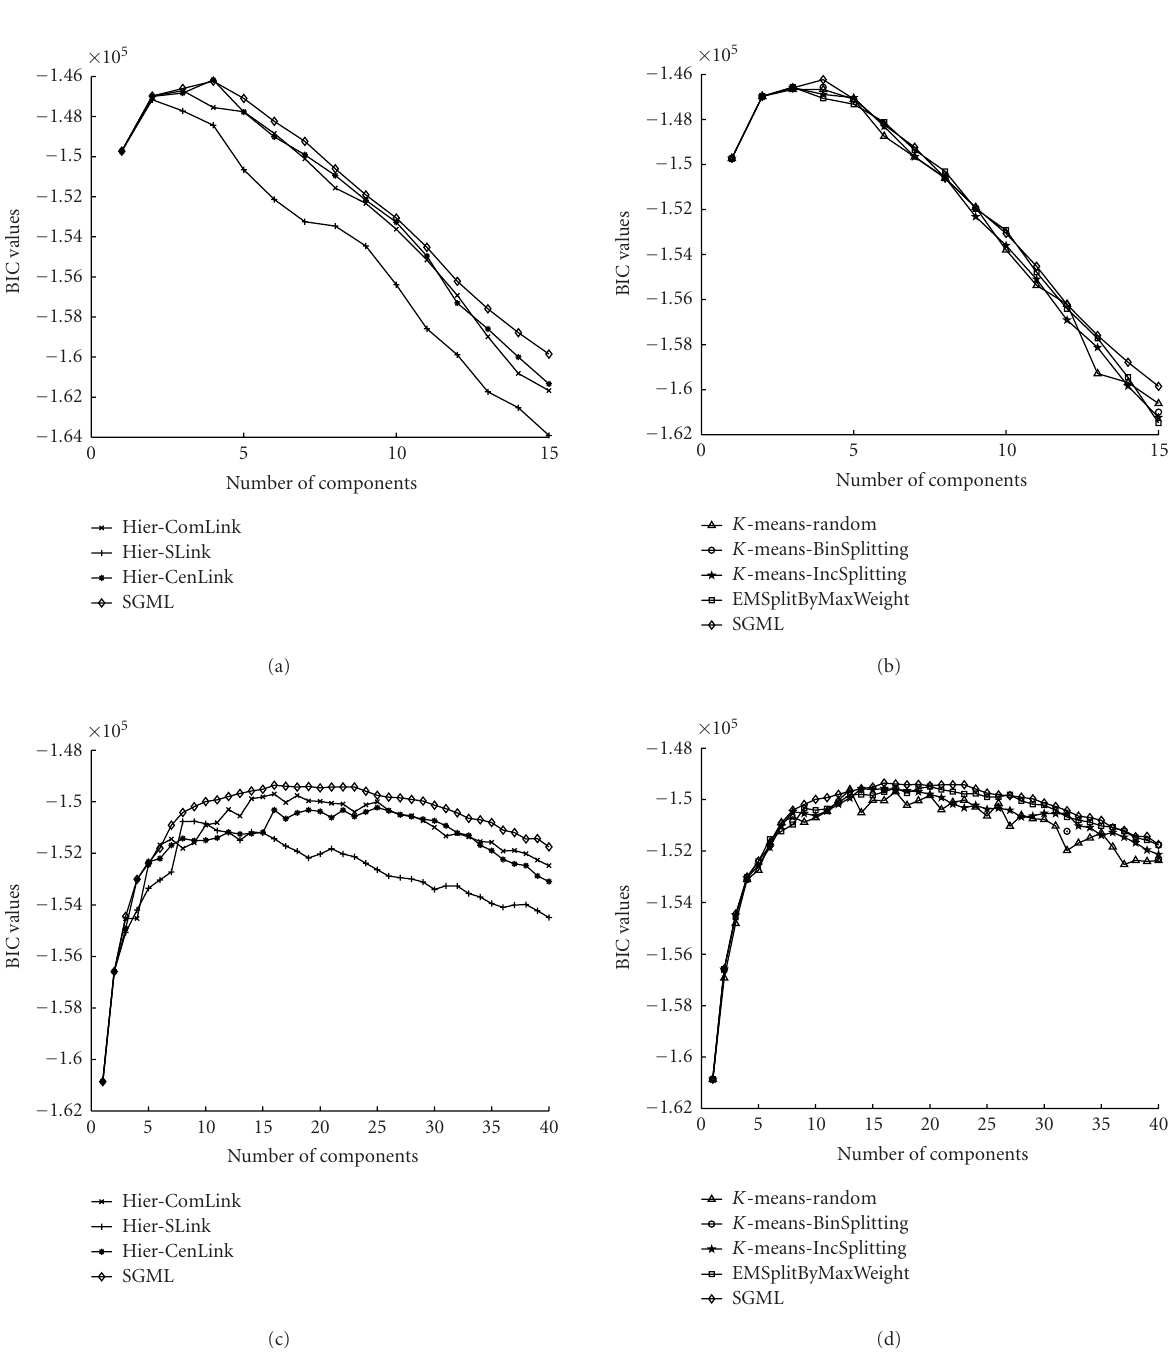
Figure 4: The learning curves of applying various GMM learning methods in the 15-second speech data of one particular male speaker in the NIST 2001 cellular data. (a) and (b) depicts the full covariance case, while (c) and (d) depict the diagonal covariance